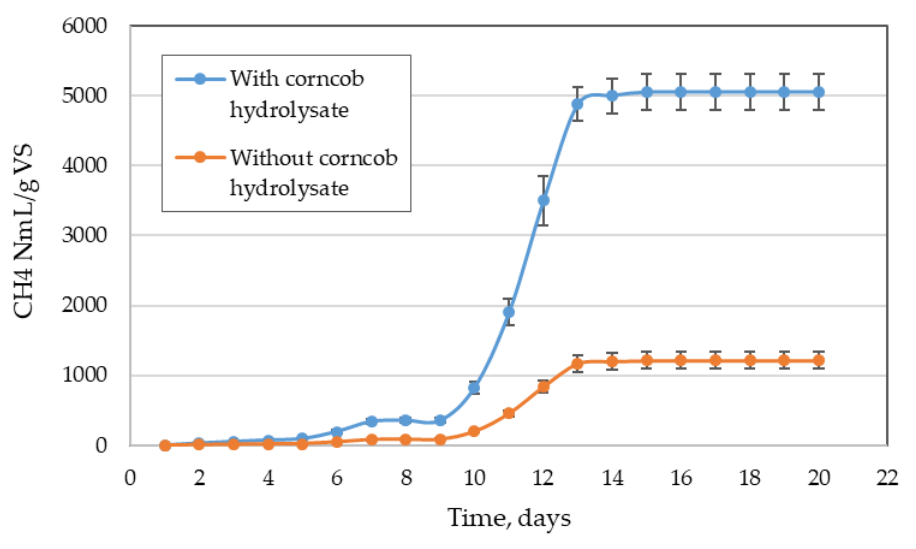
Figure 2. Cumulative biogas production in daily and total accumulated intervals.